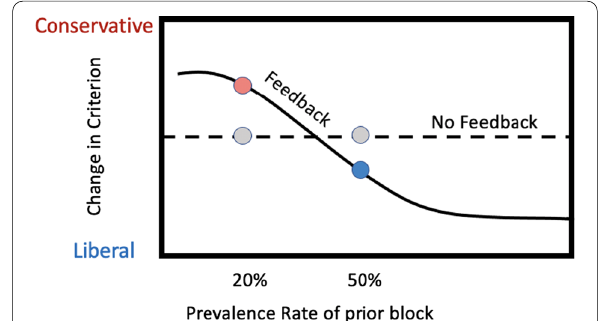
Fig. 10 Hypothetical curves showing the results of the feedback and no feedback conditions as two points on continuous